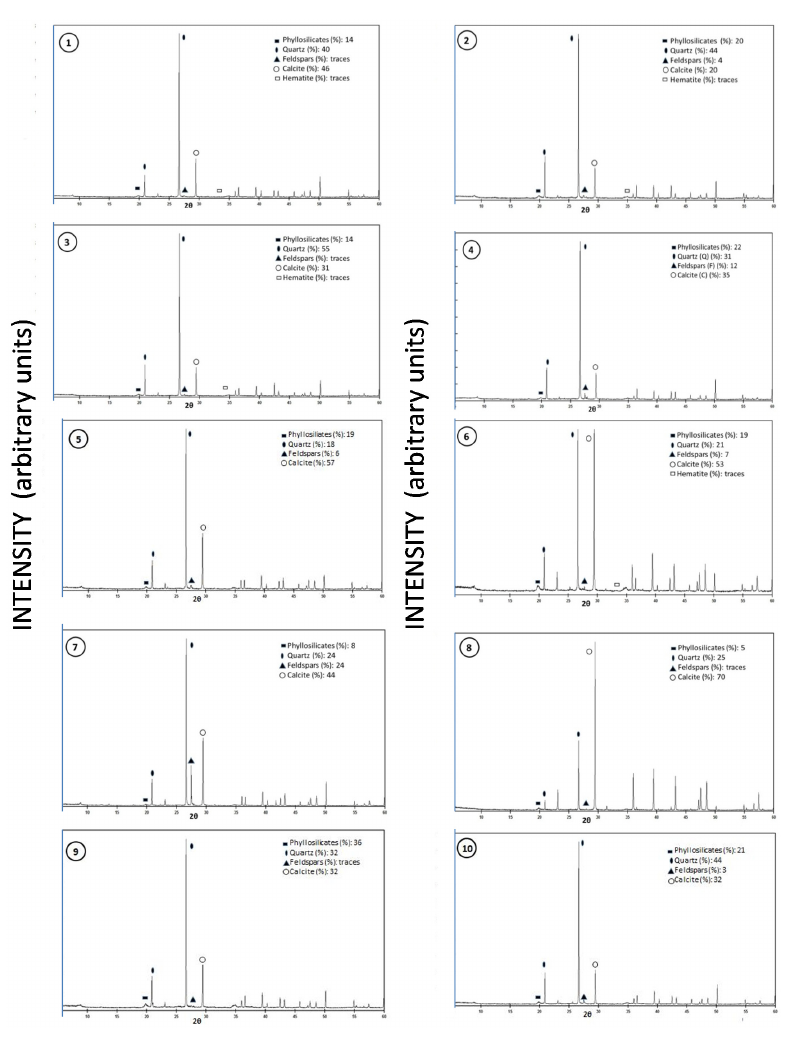
Figure 3. X-ray di ff ractograms of soil samples; (1, 2, 3, 4, 5, 6, 7, 8, 9, and 10) sample number; black rectangle = phylosilicates; black ellipse = quartz; black triangle = feldspars; circle = calcite; square = hematite.